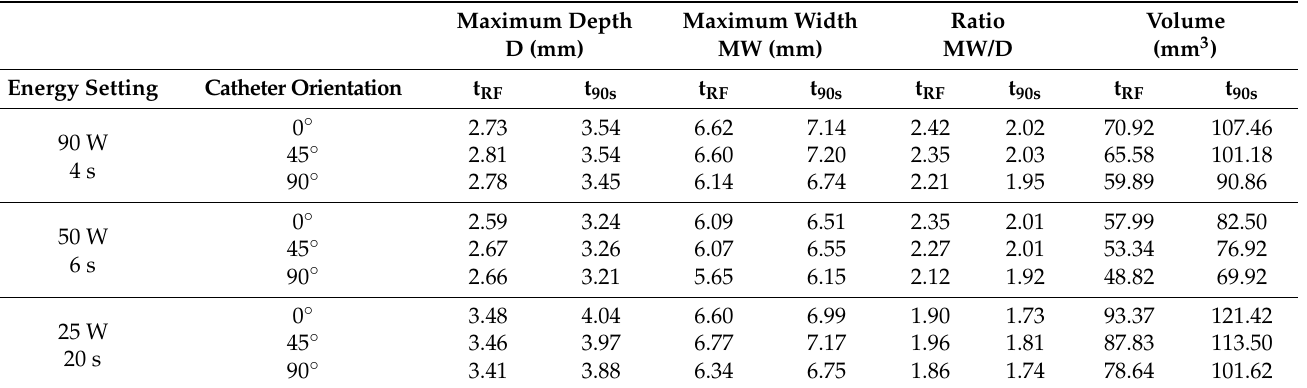
Table 2. Lesion sizes computed for different power–duration settings and catheter orientation just after the RF pulse (t RF ) and at 90 s after the onset of the RF pulse (t 90 ) in the beating heart model. Maximum Depth Maximum Width Ratio Volume D (mm) MW (mm) MW/D (mm 3 )